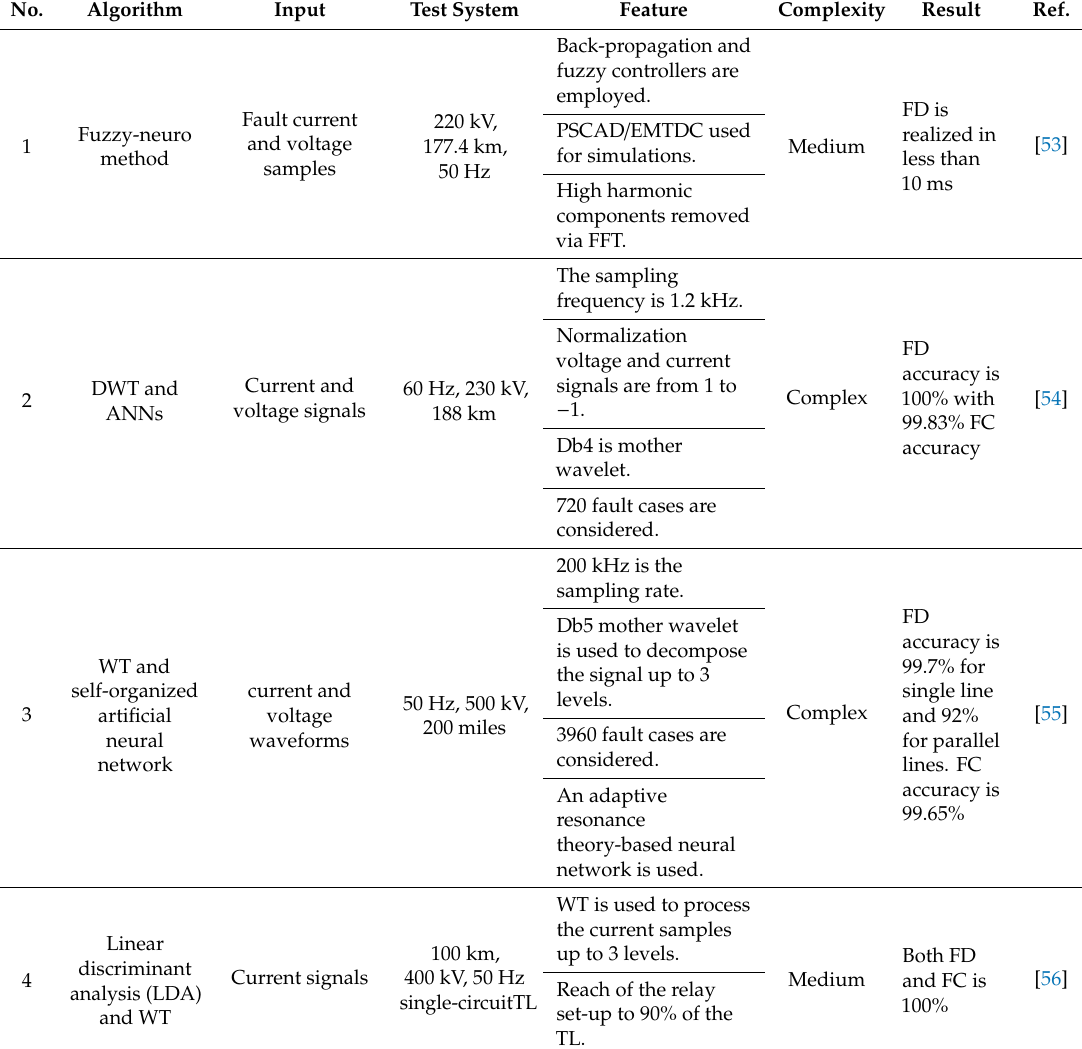
Table 1. Comparison of di ff erent fault detection